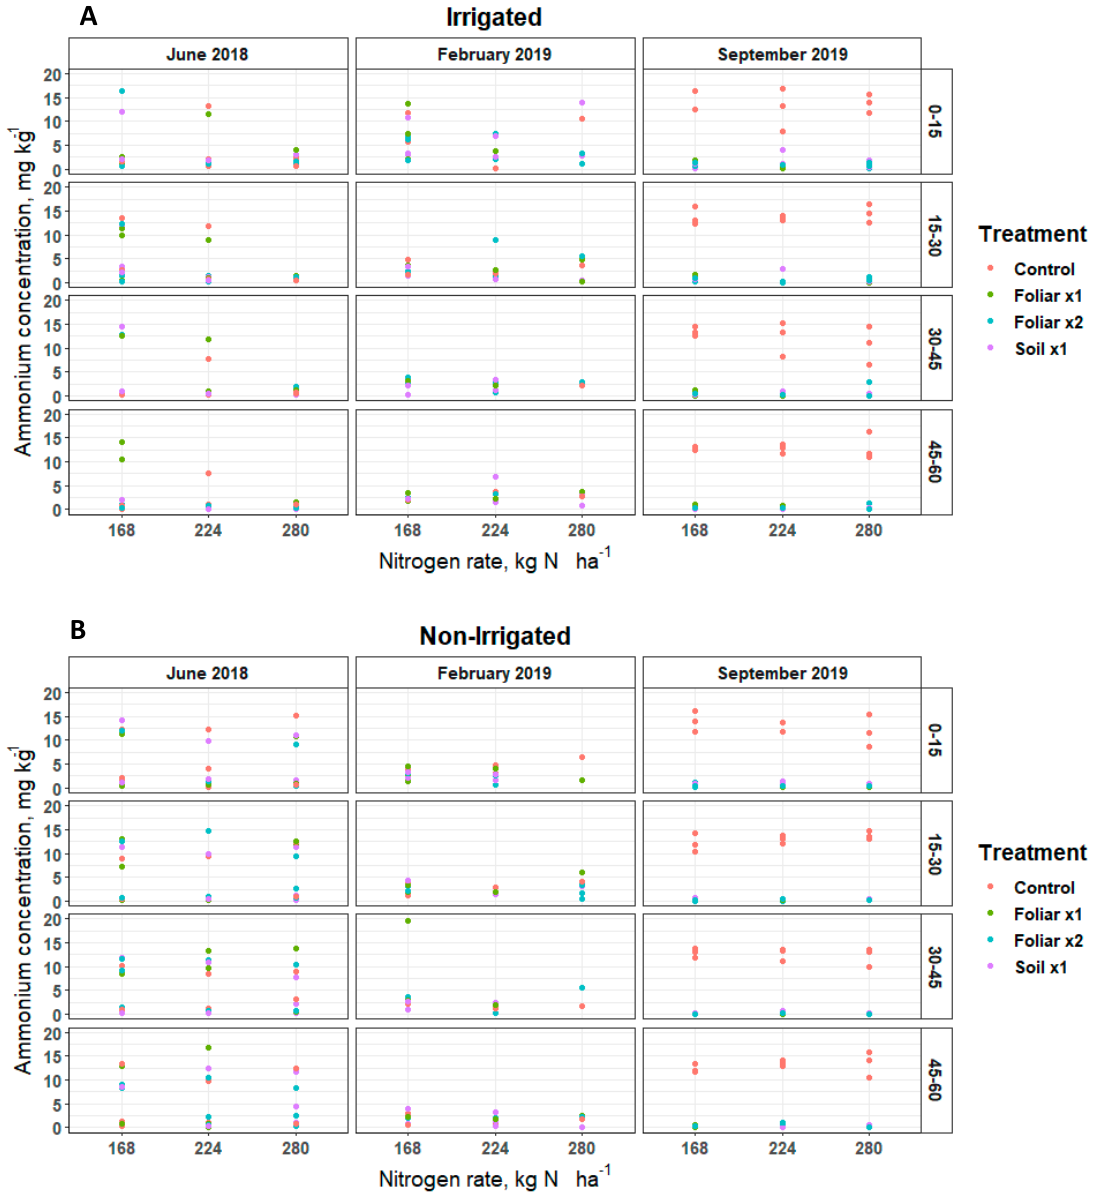
Figure 2. Soil NH + -N distribution in a Florida sandy soil after application of three levels of nitrogen 4 in irrigated ( A ) and non-irrigated ( B ) zones at 0–15, 15–30, 30–45 and 45–60 cm soil depths for three replicates. Treatments: control—standard soil Zn applied; foliar x1—standard soil Zn applied + foliar-applied Zn based at 1 × UF / IFAS recommendations; foliar x2—2 × foliar-applied Zn at UF / IFAS recommendations + standard soil Zn application; soil x1—2 × soil-applied UF / IFAS recommendations (5.60 kg Zn ha − 1